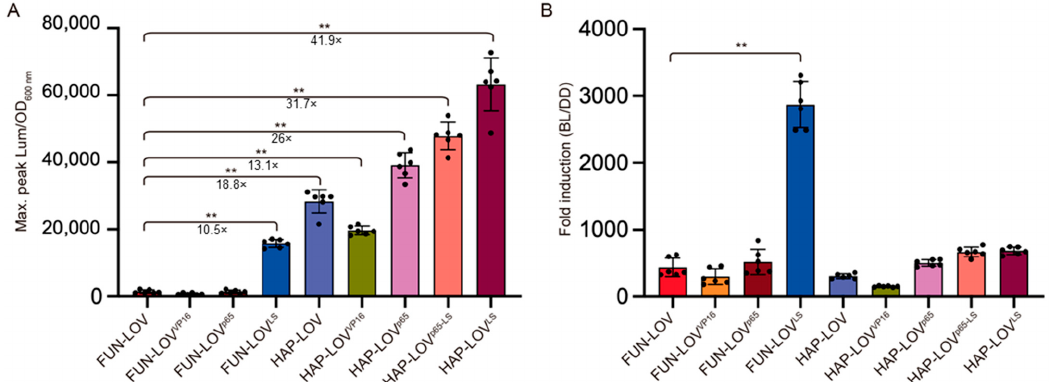
Figure 6. Dynamic range exhibited by the different optogenetic systems tested in this work. ( A ) The maximal peak of normalized luciferase expression for each optogenetic system was measured during a blue-light pulse of 120 min. ( B ) Luciferase activity fold-induction for each optogenetic system upon a blue-light (BL) pulse of 120 min, compared to the constant darkness (DD) condition. The graph shows the average of six biological replicas. ** Double asterisks indicate a statistically significant difference with respect to the original FUN-LOV system ( t -test, p <